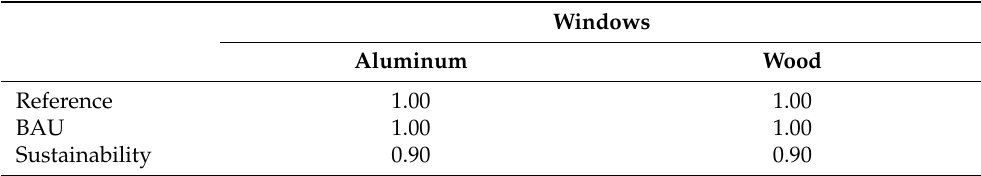
Table 7. U-values (W/m 2 K) of cost-optimal windows, using different frame materials, under different economic scenarios.